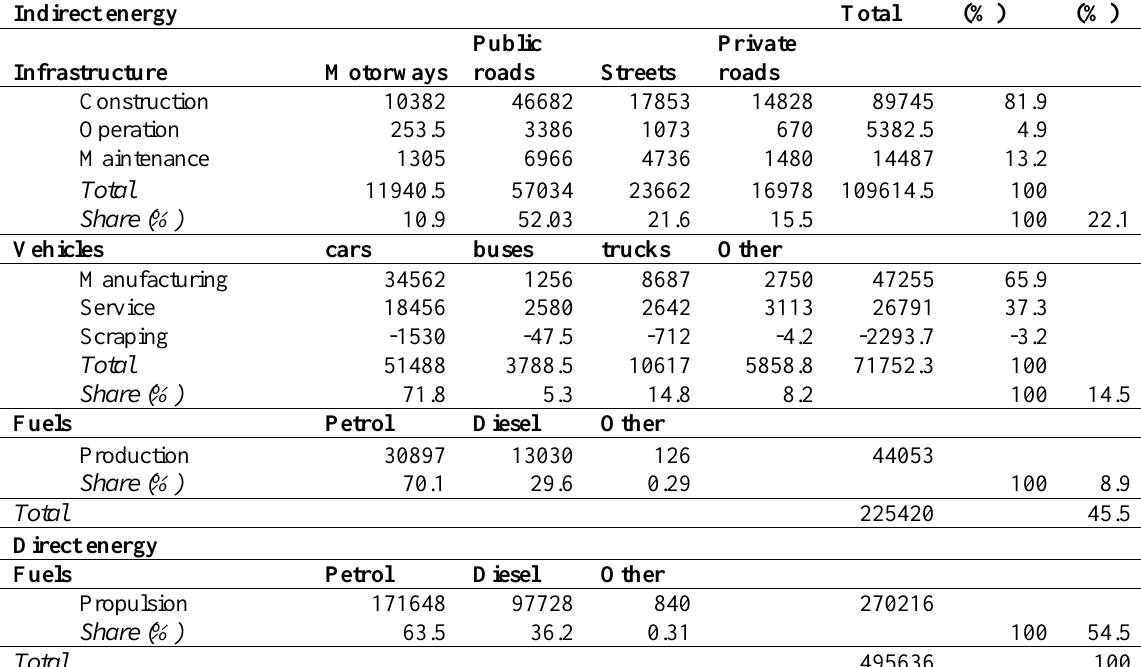
Table 4. Annual energy associated with Swedish road transport [TJ] Indirect